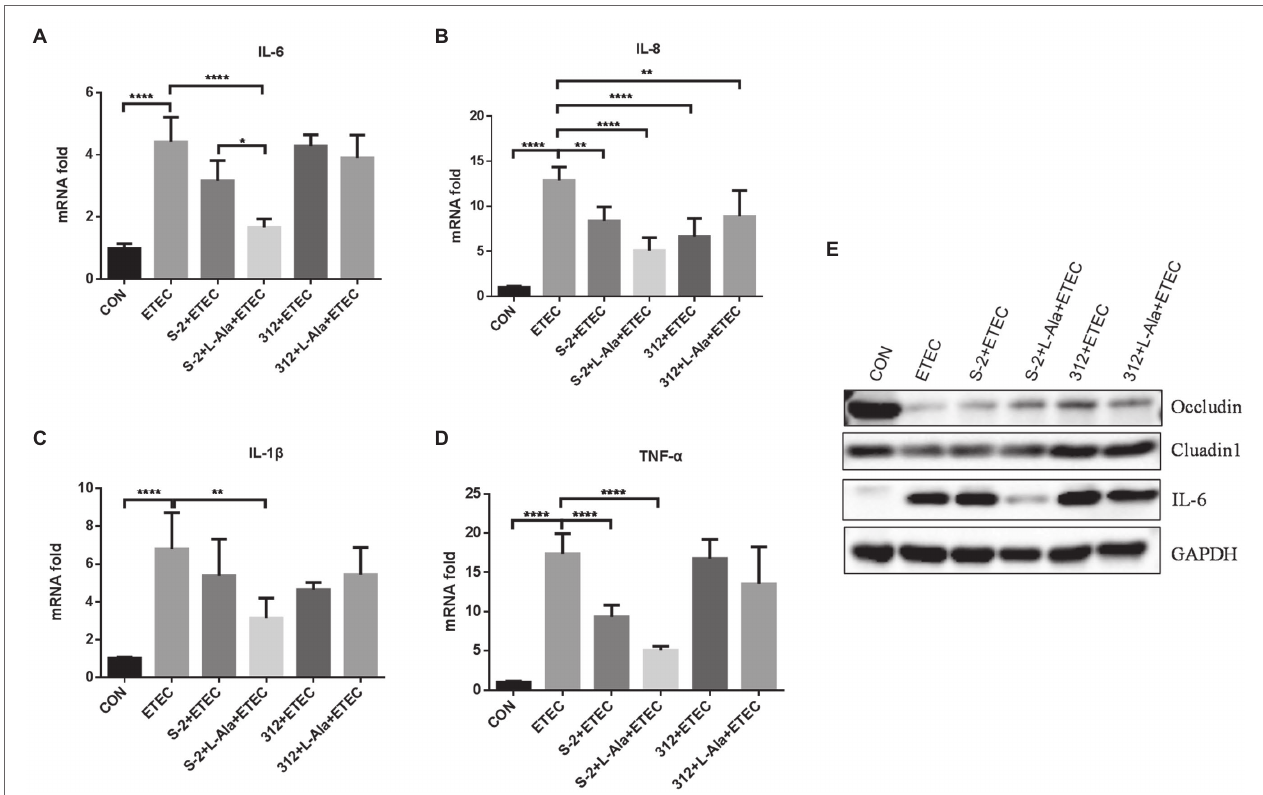
FIGURE 5 | The different effects of L-alanine mediated B. subtilis S-2 and 312 strains on inflammatory cytokines and tight junction proteins in IPEC-J2 cells. IPEC-J2 cells were incubated with B. subtilis S-2 and 312 spores (10 6 CFU/ml) with or without L-alanine pre-treated for 16 h. Then the cells were infected with ETEC-K99 (10 6 CFU/ml) for 12 h. The mRNA expression of IL-6 (A) , IL-8 (B) , IL-1 β (C) , TNF- α (D) were detected by RT-qPCR; (E) The protein expression of occludin, claudin, and IL-6 were tested by WB. Values are expressed as the mean ± SD from three independent experiments. * p < 0.05; ** p < 0.01; **** p < 0.0001, as calculated by one-way ANOVA with Tukey’s multiple comparisons test. Groups with no significant difference were not